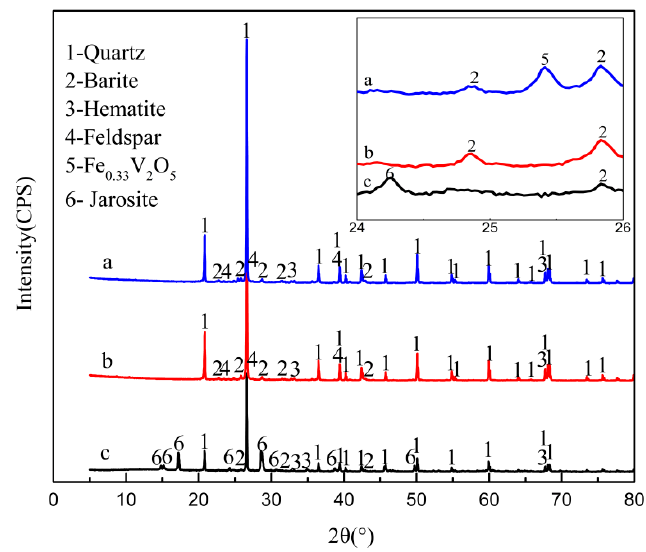
Figure 8. XRD patterns of raw ore and leached residues. ( a ) raw ore, ( b ) residue obtained after 1.2 days and ( c ) residue obtained after 10 days.